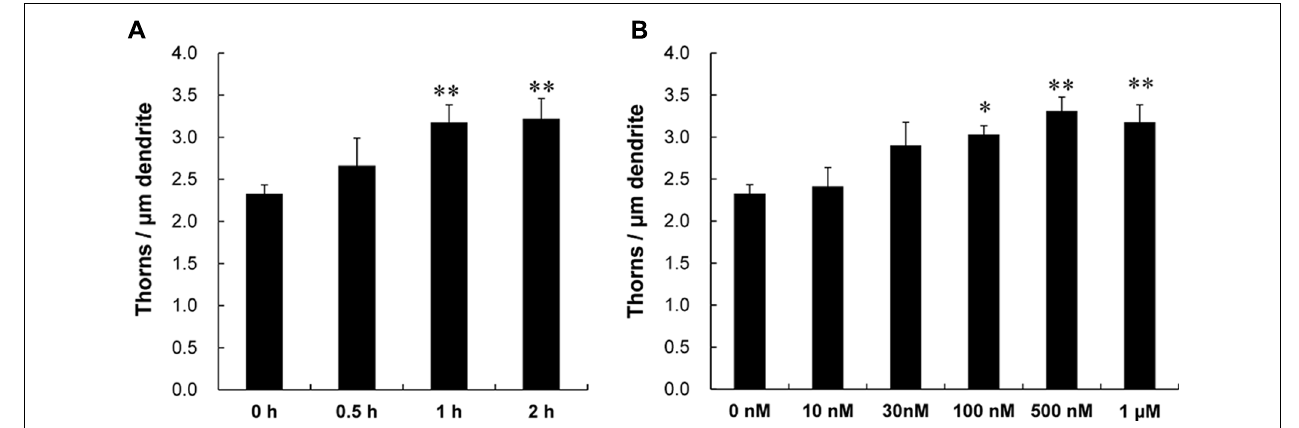
(10 nM), with 30 nM CORT (30 nM), with 100 nM CORT (100 nM), with 500 nM CORT (500 nM), and with 1 μ M CORT (1 μ M).Vertical axis is the average number of thorns per 1 μ m of dendrite. Results are reported as mean ± SEM.The significance of CORT or drug effect was examined using theTukey–Kramer post hoc multiple comparisons test when one way ANOVA tests yielded P < 0.05.The significance yielded ** P < 0.01 * P < 0.05,